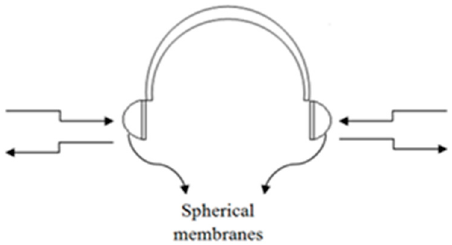
Figure 34. The design of ultrasonic headset [55].